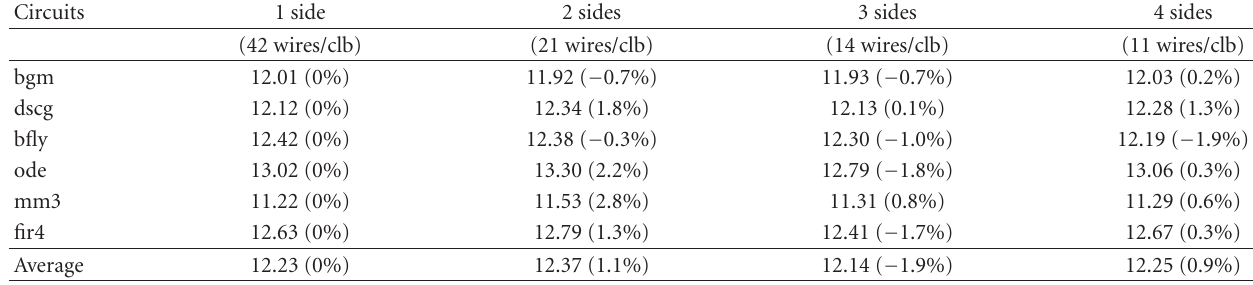
Table 3: Critical path delay in ns for di ff erent EB’s I/O positions as shown in Figure 5 for single EB-type FPGA. The percentage shows the deviation from the 1 side result.